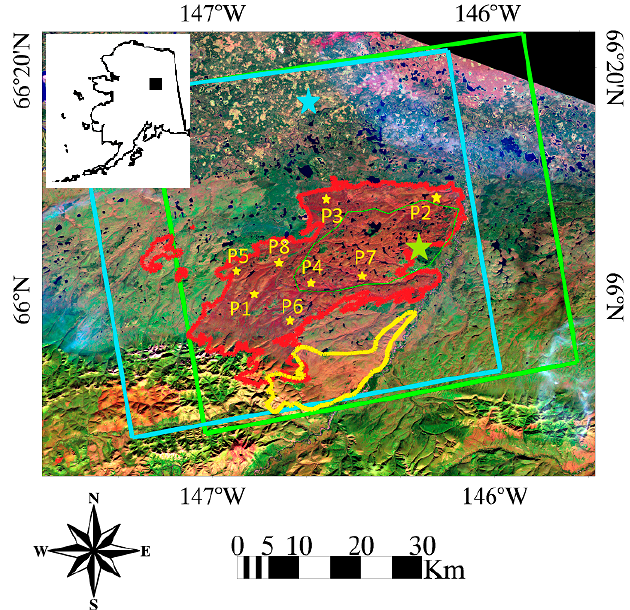
Figure 1. The map of 2009 (red) and 2005 (yellow) wildfire perimeters in the study area (The Bureau of Land Management Alaska Fire Service (http://afs.ak.blm.gov/)). The study area covered by paths 252 and 251 (ALOS) are boxed in cyan and green, respectively. Points P1, P2, P3, P4, P5, P6, P7, and P8 are selected points to evaluate InSAR results. The reference point and the location of ground truth measurements are shown by the cyan and green stars, respectively. The area in a green polygon is densely populated by lakes and ponds. The background image of figure is a post-fire false color composite of Landsat ETM+ bands 7 (R), 4 (G), and 2 (B).